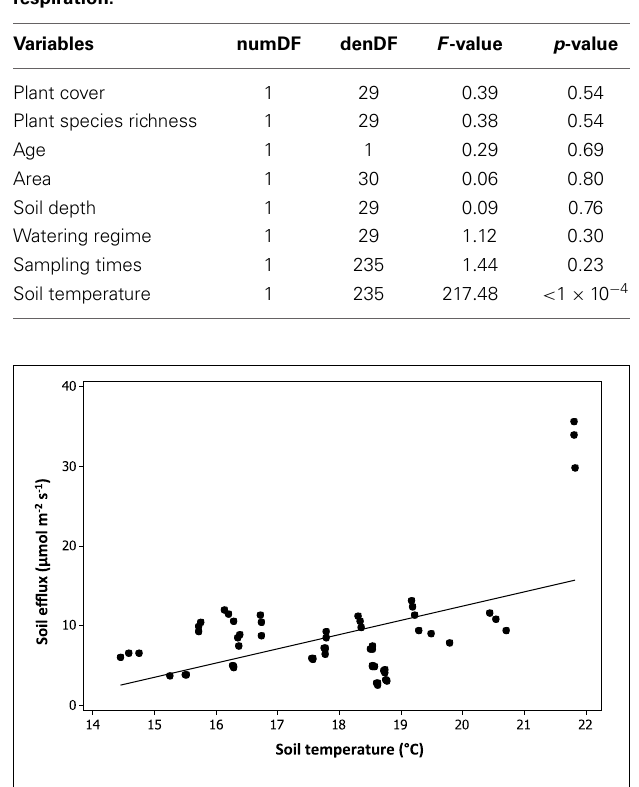
FIGURE 5 | Modeled relationship between soil CO 2 respiration and soil